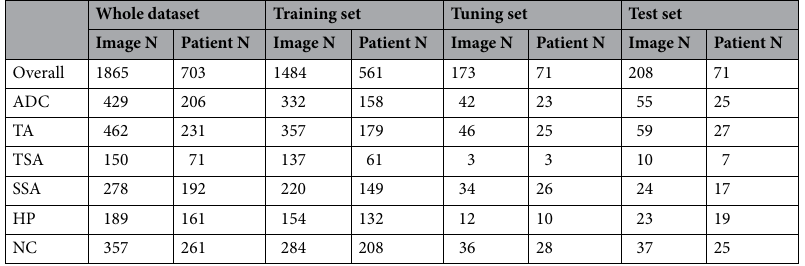
Table 1. Data composition for the firstly split datasets for building deep learning models. ADC advanced tubular adenocarcinoma, TA tubular adenoma, TSA traditional serrated adenoma, SSA sessile serrated adenoma, HP hyperplastic polyp, NC nonspecific